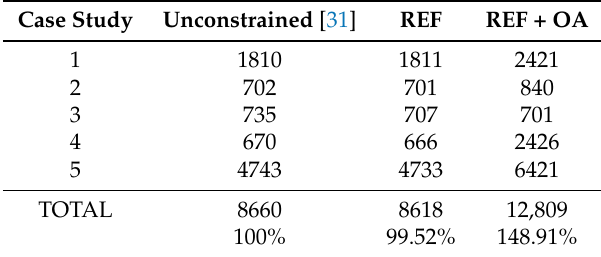
Table 2. Total number of detections for the unconstrained system [31], the system with reprojection error filtering (REF), and the system with reprojection error filtering and orientation alignment (REF + OA).